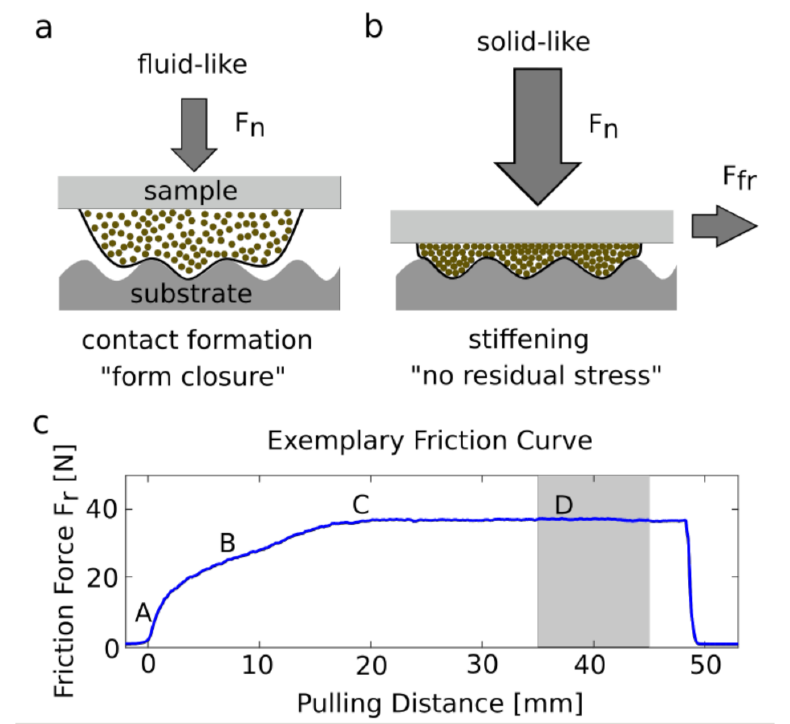
Figure 1. Granular media friction pad (GMFP). ( a ) Fluid-like behavior when coming into contact with a substrate [1], ( b ) solid-like behavior upon applying normal load (jamming transition), ( c ) exemplary friction curve showing the four phases of a pulling curve at a normal load F n = 19.36 N: (A) initial shearing of jammed granular media, (B) stretching of the membrane in addition to granular media shearing, (C) maximum static friction force and onset of global dynamic friction, (D) dynamic sliding of the entire